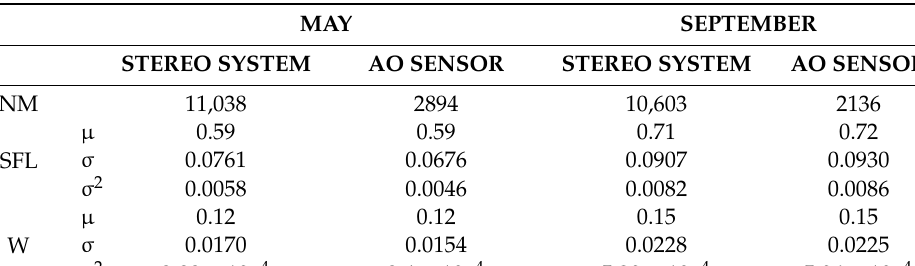
Table 4. Statistical comparison between acoustic–optical (AO) sensor and stereoscopic system. NM: number of measurements; µ: population mean; σ: standard deviation; σ 2 : variance.